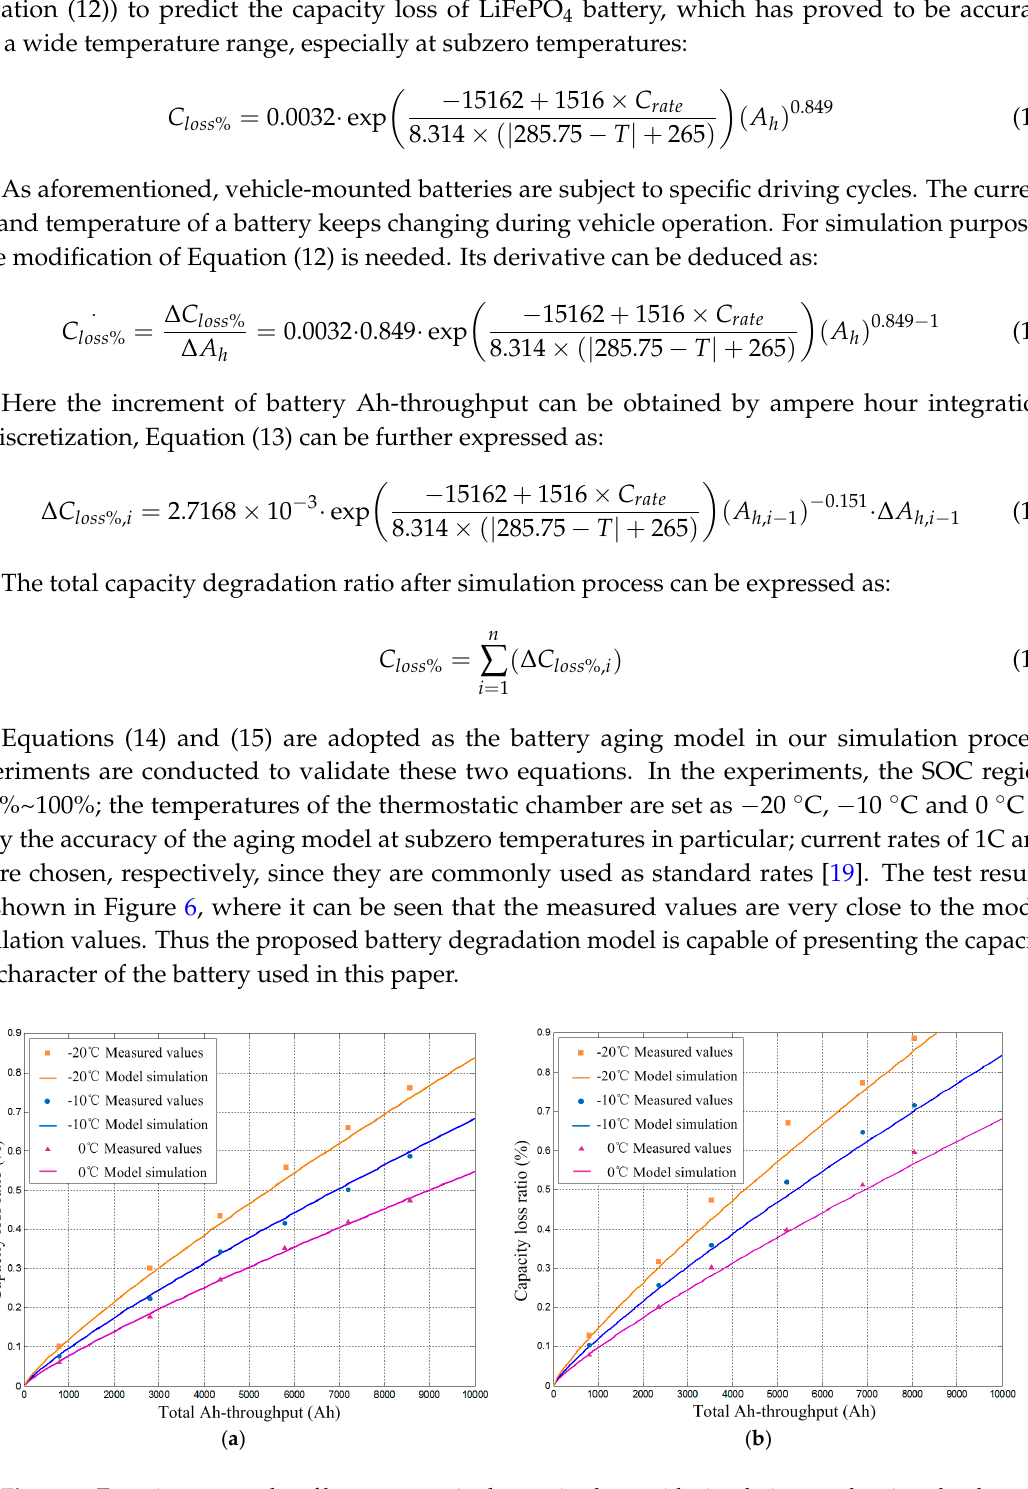
Figure 6. Experiments results of battery capacity loss ratio along with simulation results given by the degradation model at ( a ) 1C current rate and ( b ) 2C current rate.